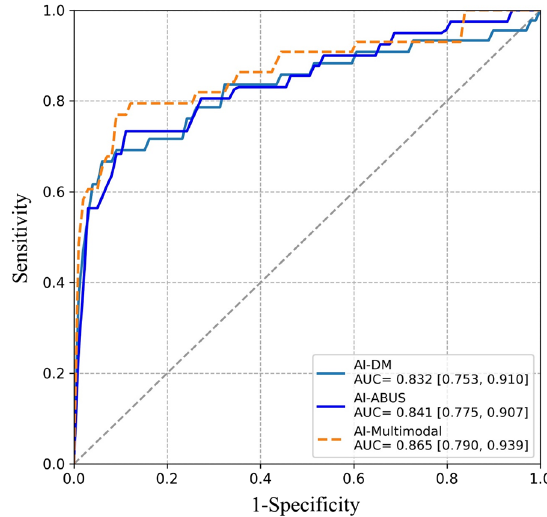
Fig. 1 Receiver operating characteristic curve comparison (and their area under the curve, AUC) among AI‑DM, AI‑ABUS and AI‑Multimodal in full